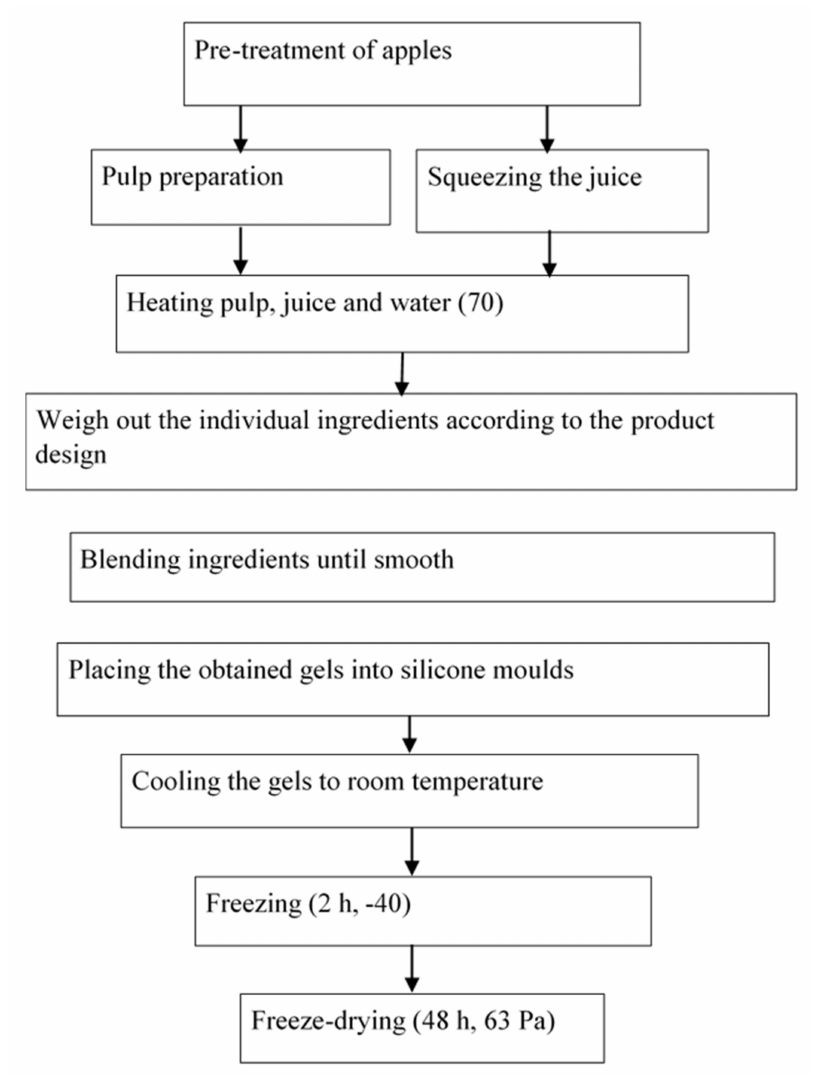
Figure 10. Process diagram for obtaining freeze-dried food